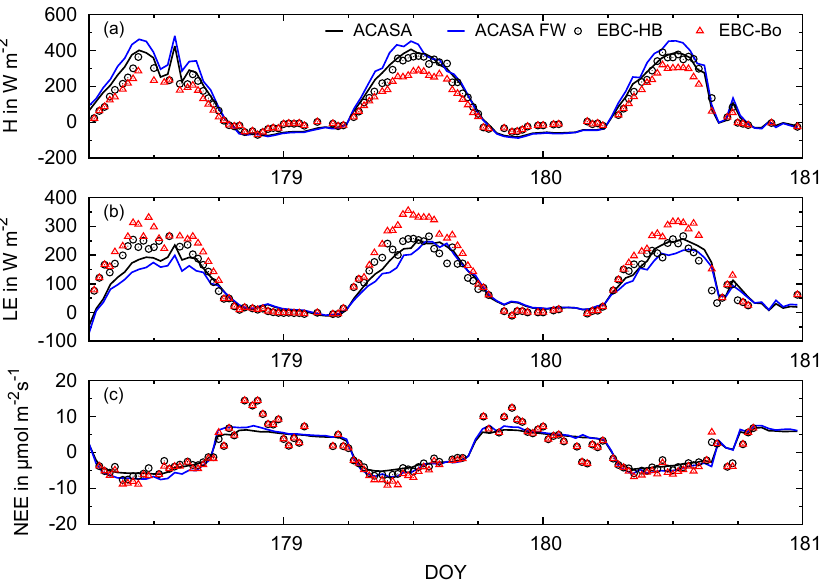
Figure 3. Comparison of ACASA model simulations with measured turbulent fluxes at the TM (5.5m measurement height) for the first GDP; (a) sensible heat ( H ), (b) latent heat ( LE ), and (c) net ecosystem exchange (NEE). The black solid line displays ACASA simulations weighted by the mean plant distribution of the whole clearing and the blue solid line indicates ACASA simulations weighted by different plant classes within the footprint of the flux measurements. Energy-balance-corrected flux measurements are shown by black circles for the correction utilizing the buoyancy flux ratio (EBC-HB) and red triangles for correction with the Bowen ratio (EBC-Bo).